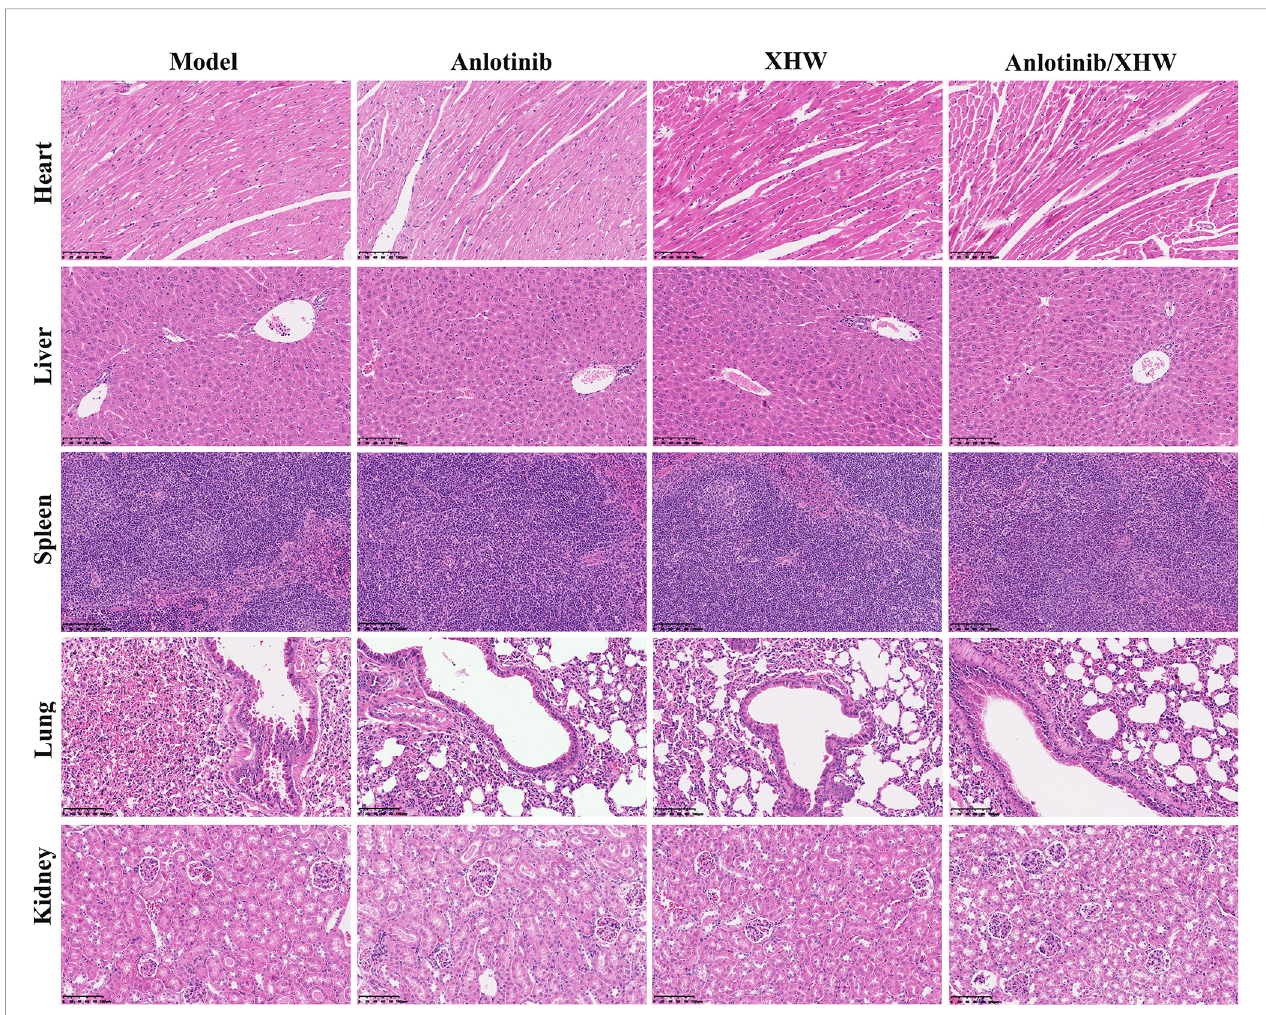
FIGURE 2 | Representative microphotographs of the heart, liver, spleen, lung, and kidney of the mice bearing LLC after treatment for 21 days.